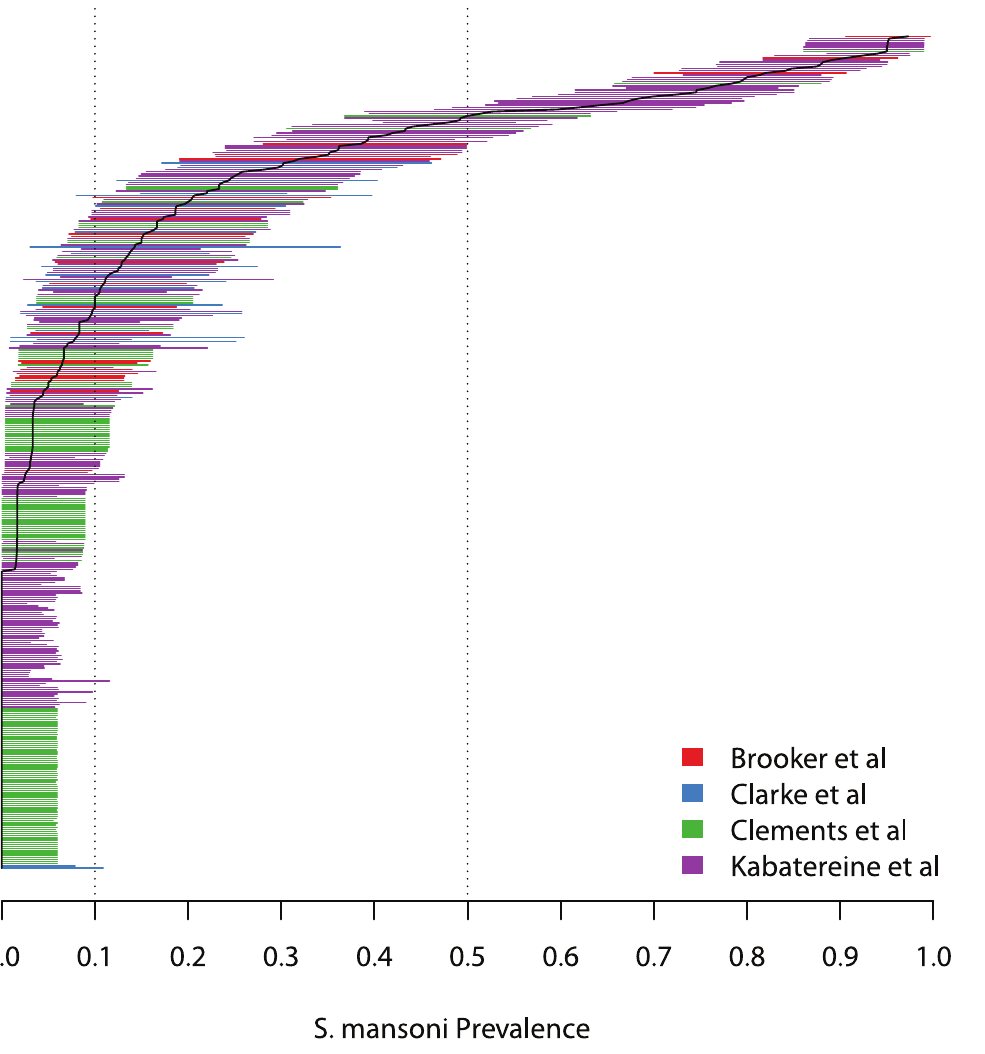
Figure 2. Prevalence of S.mansoni in 388 East African schools. Horizontal lines are 95% exact confidence intervals.